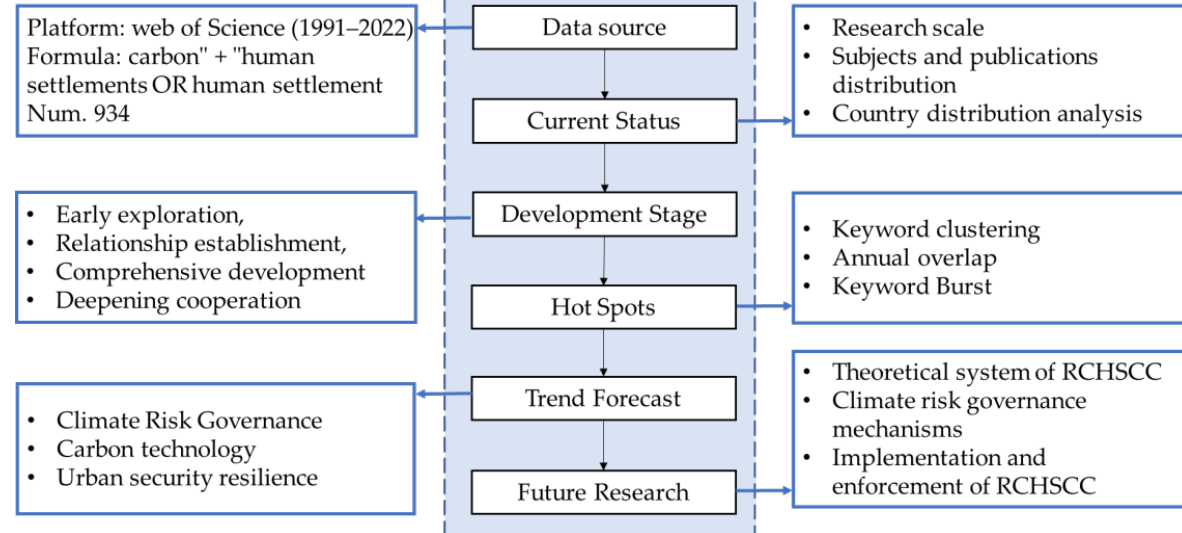
Figure 1. RCHSCC ’ s framework. Figure 1. RCHSCC’s